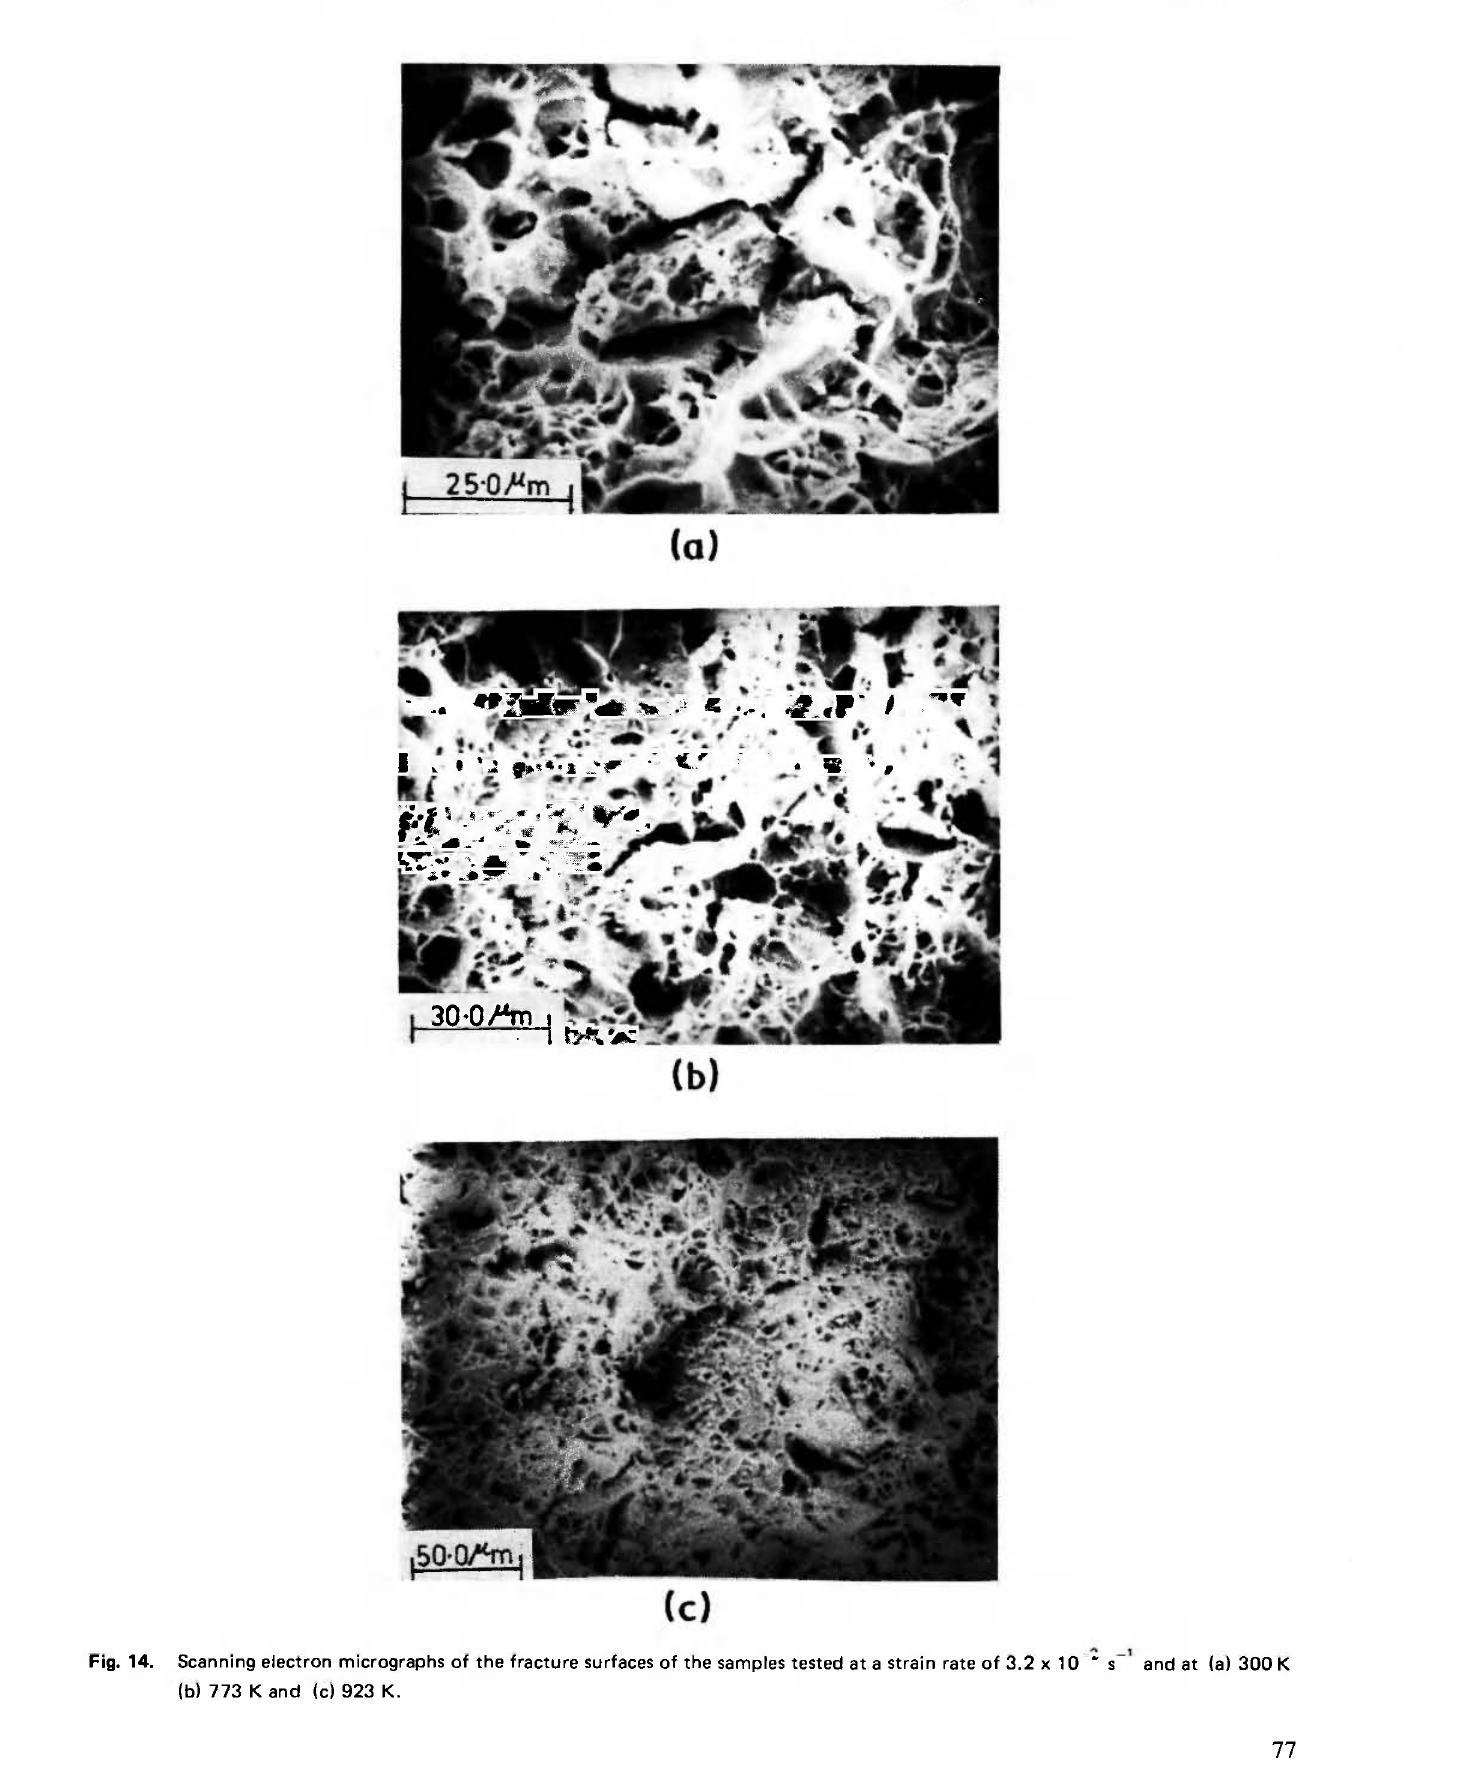
Fig. 14. Scanning electron micrographs of the fracture surfaces of the samples tested at a strain rate of 3.2 χ 10 s and at (a) 300 Κ (b) 773 Κ and (c) 923